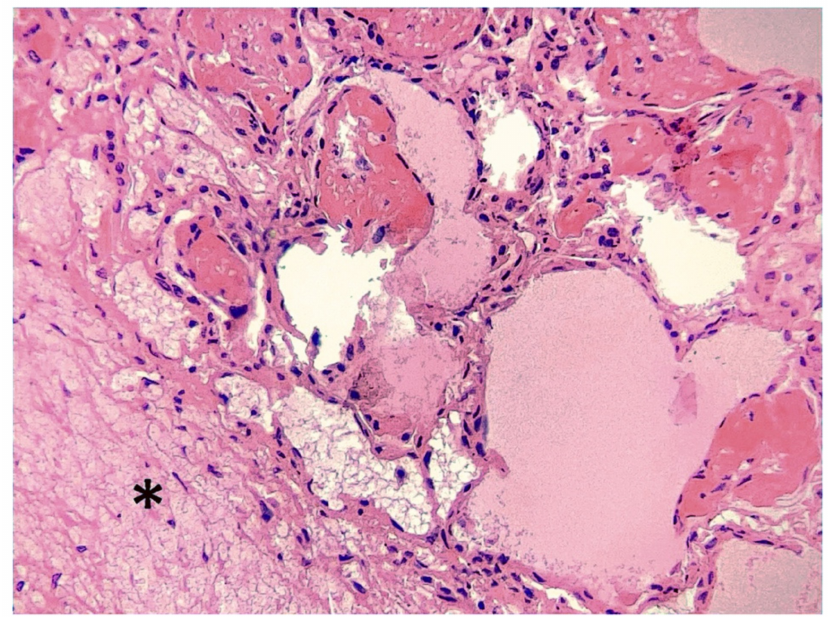
Figure 4. Lungs. Almost all alveoli are edematous or filled with fibrin. The interlobular septa (*) are thickened and embedded by abundant fibrinous exudate (HE, magnification ×